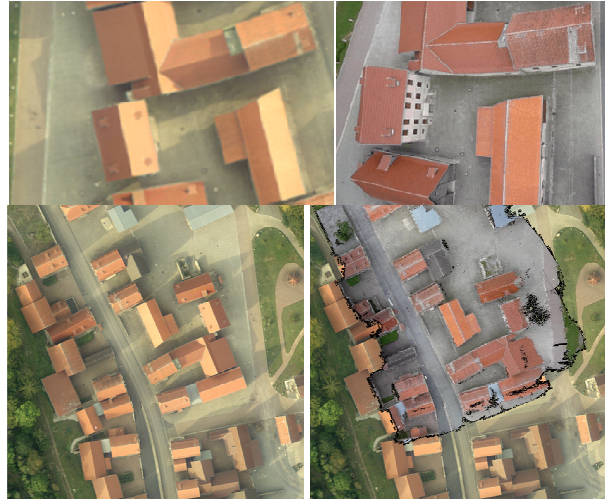
Figure 6: Top: the differences in resolution and appearance of the orthophoto (left) and a video frame (right) are enormous if the altitude of the sensor platform is low. Bottom: the workspace has been geo-referenced by registration of the synthetic image to an